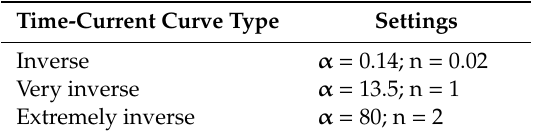
Table 1. Parameters for di ff erent relay characteristics according to the IEC 60255-151 standard.